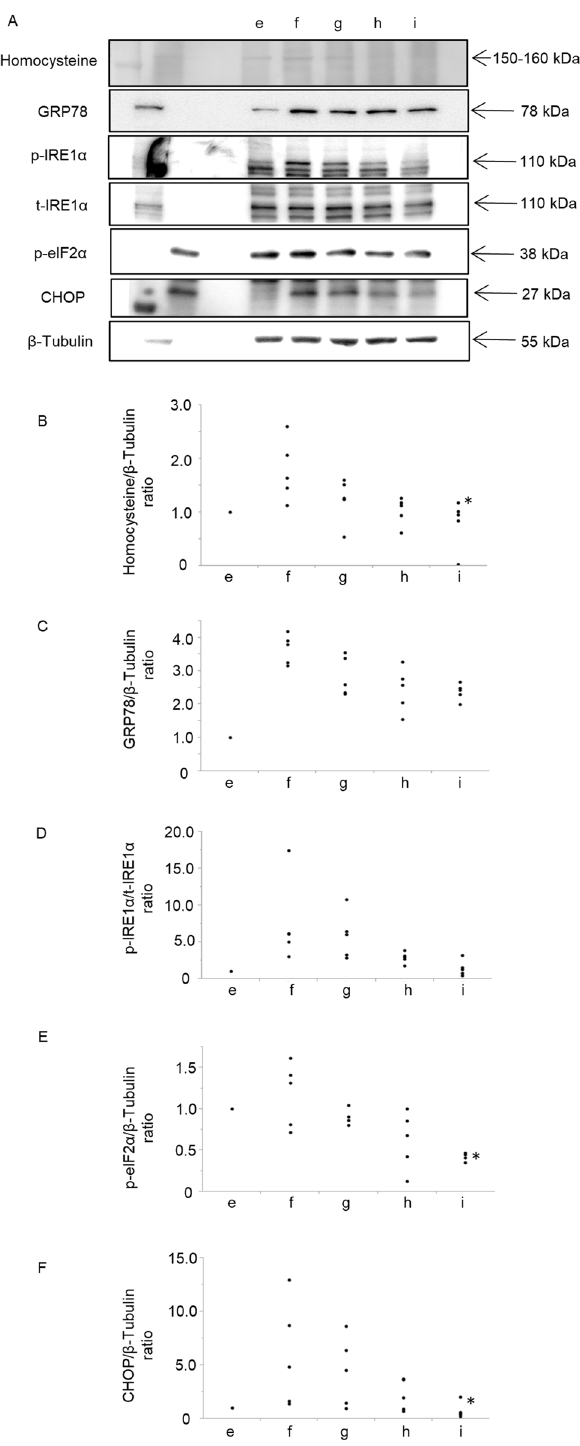
Figure 5. Vitamin B12 (VB) and folate (Fo) improved endoplasmic reticulum (ER) stress induced by homocysteine and cigarette smoke extract (CSE) in A549 cells. To investigate the effect of vitamin B12 and folate supplementation on the protein levels of ER stress-related molecules, A549 cells were pretreated with the same concentration of vitamin B12 and folate adjusted to 5 ‒ 50 μM for 12 h, followed by stimulation with 5 mM homocysteine plus 20% CSE. ( A ) Graphic depictions of western blotting. ( B – F ) Quantitative analysis for protein expression of homocysteine, GRP78, phosphorylation of IRE1α, expression of p-eIF2α, and CHOP by western blotting. The protein expression levels of homocysteine, p-eIF2α, and CHOP induced by CSE and homocysteine were significantly decreased by pretreatment of vitamin B12 and folate in a dose-dependent manner. e; 20% CSE, f; 20% CSE+ homocysteine 5 mM, g; 20% CSE+ homocysteine 5 mM+ vitamin B12 and folate 5 μM, h; 20% CSE+ homocysteine 5 mM+ vitamin B12 and folate 25 μM, i; 20% CSE+ homocysteine 5 mM+ vitamin B12 and folate 50 μM. n = 5 in each group. Differences between groups were examined using Bonferroni/Dunn test. *P < 0.05 vs 20% CSE+ homocysteine 5 mM. CSE cigarette smoke extract, CHOP CCAAT/enhancer binding protein homologous protein, GRP78 78-kDa glucose-regulated protein, p-IRE1α phosphorylation of inositol-requiring enzyme 1, p-eIF2α phosphorylate eukaryotic translation initiation factor